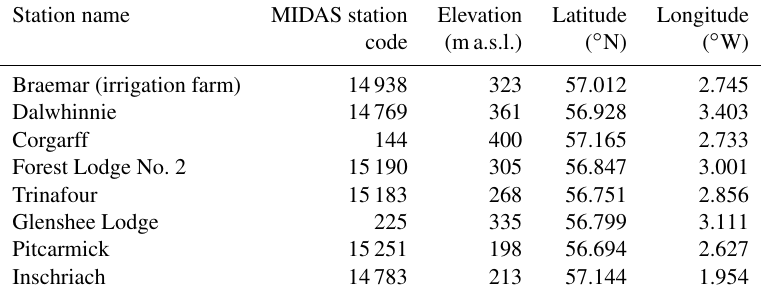
Table A1. MIDAS (Met Office Integrated Data Archive System) weather stations used for the construction of the regression equa- tions for orographic temperature and precipitation